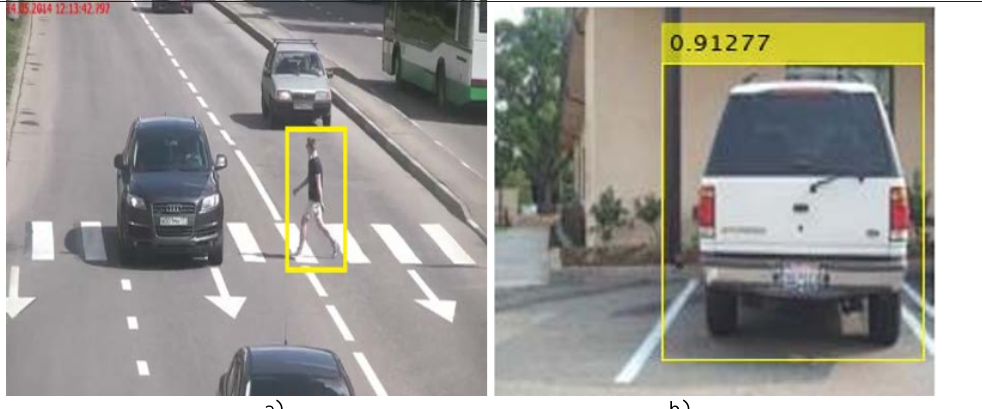
Fig. 6. Detection of objects of interest. a) car b)